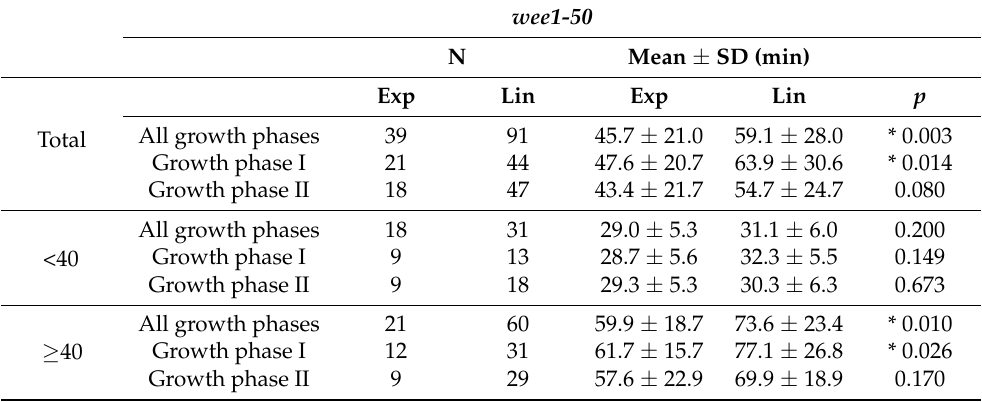
Table 3. Results of the two-sample t -tests for analysing the growing phases in those wee1-50 mutant cells, which grew bilinearly.